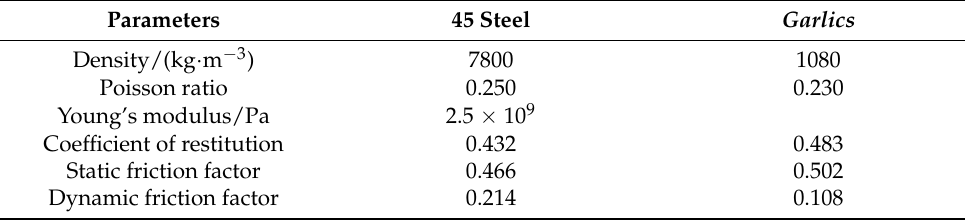
Figure 6. Simulation model and simulation working state diagram. ( a ) Multi-sphere representation of the garlic seeds; ( b ) EDEM simulation of the seed rower operating state. Table 3. Simulation parameters of garlic seed picking.